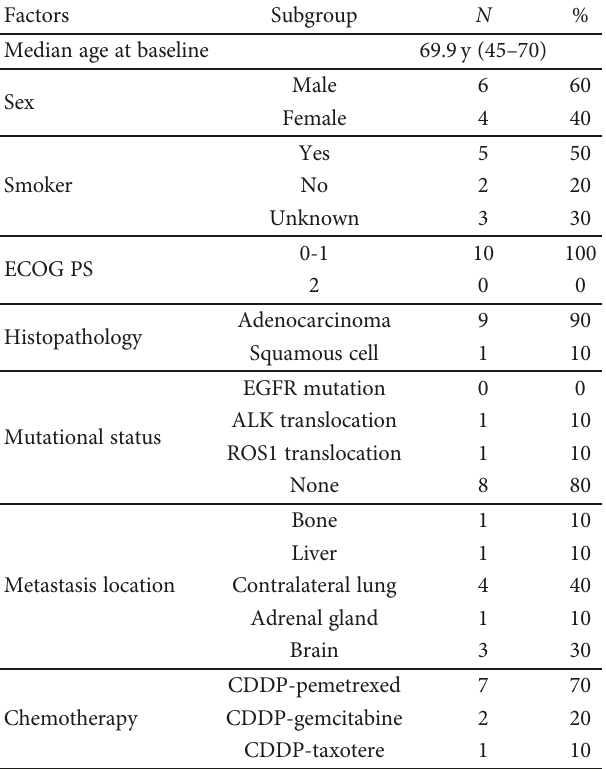
Table 2: Clinical and histopathological characteristics of ten non- small cell lung cancer